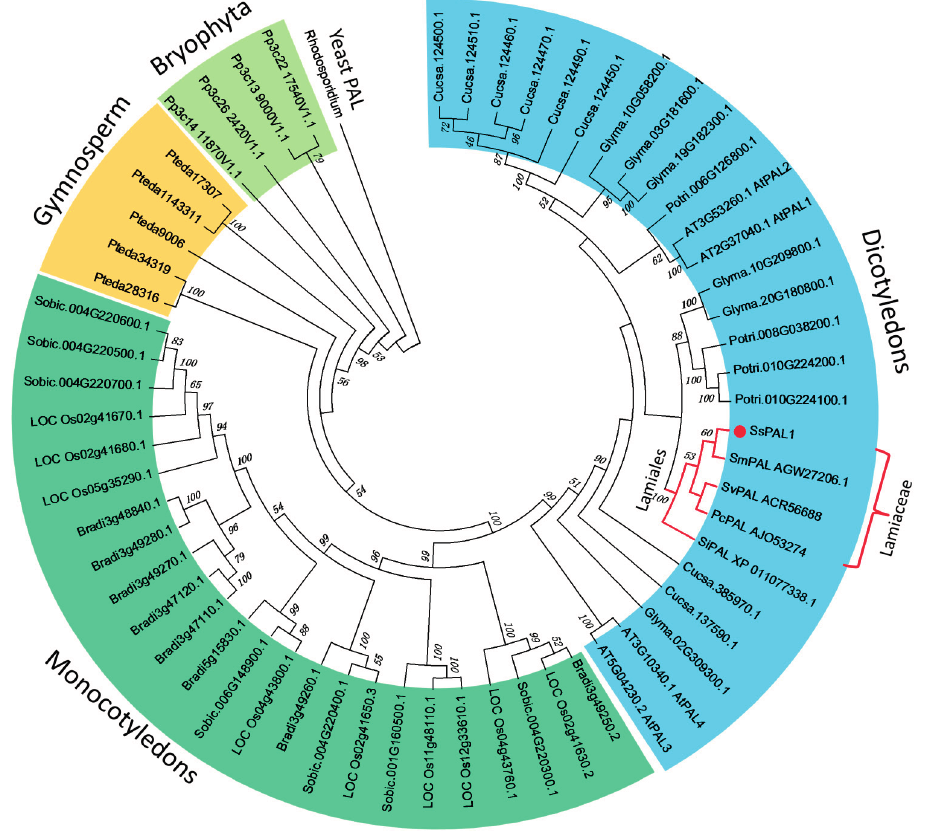
Figure 4. Phylogenetic tree of the plant PAL gene family. The amino acid sequences are aligned by ClustalX (1.81) and the neighbor-joining (NJ) tree as constructed using the program MEGA6.0. Numbers above branches are bootstrap values (>45%). SsPAL1 is marked with a red dot, and the order Lamiales is marked with red